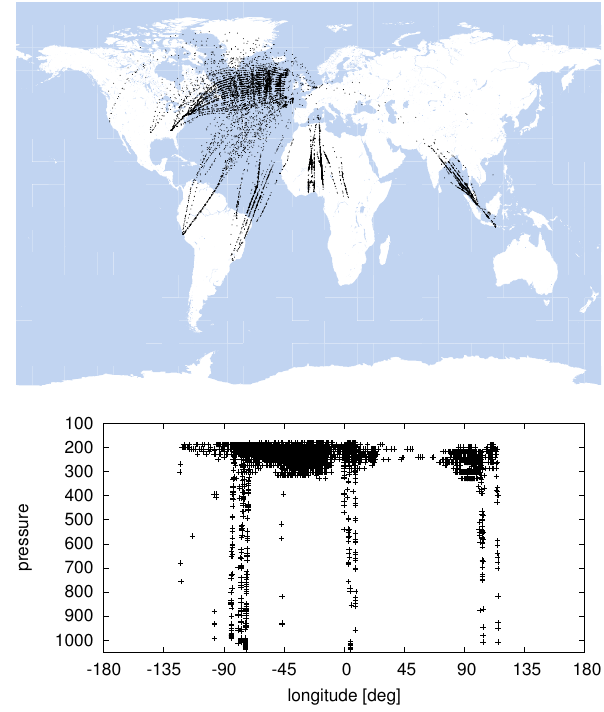
Fig. 2. Horizontal and vertical distribution of ADS-C